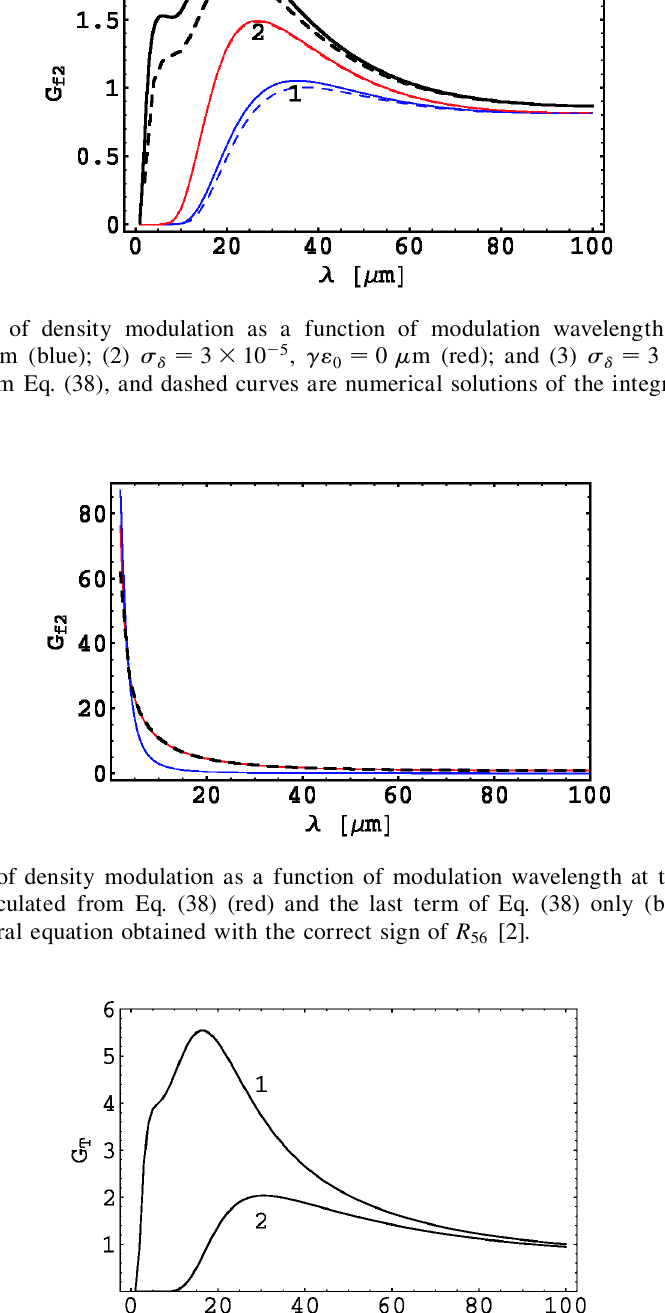
FIG. 5. Total amplification factor G of BC1 and BC2 as a function of modulation wavelength at the entrance of BC2 (1) without T the wiggler and (2) with the wiggler.